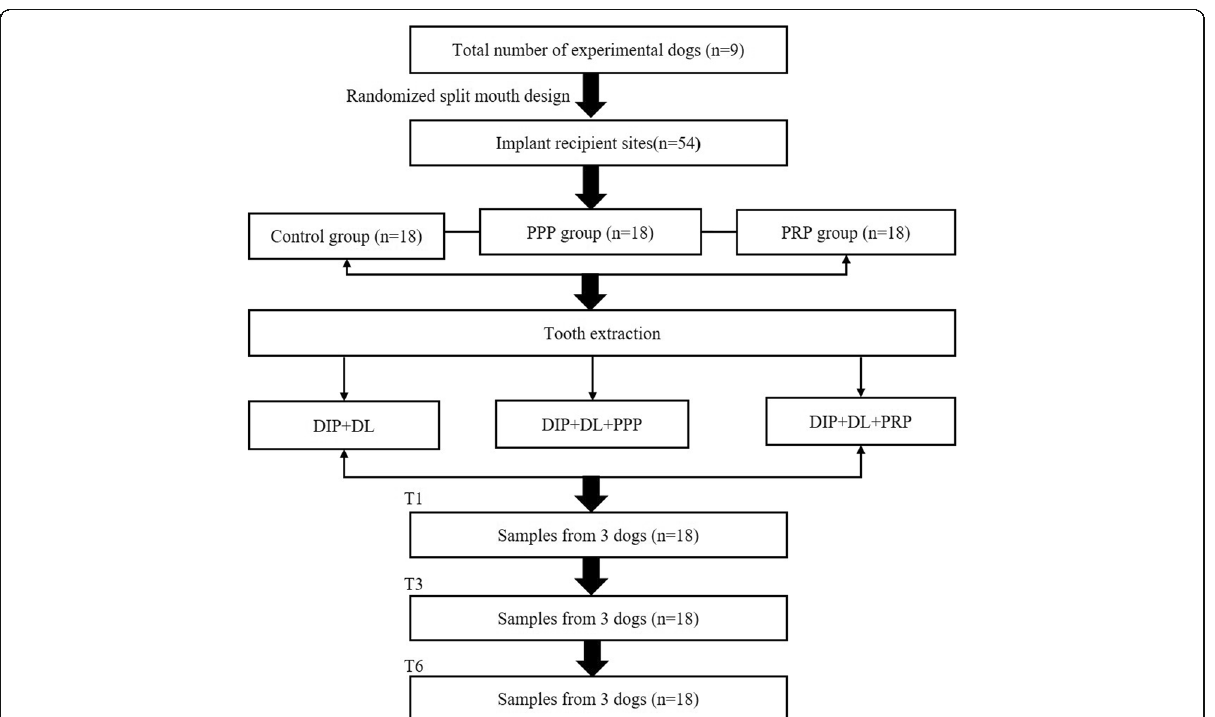
Fig. 1 Flow chart of study design. DIP+DL, delayed implant placement and delayed loading. PPP, platelet-poor plasma; PRP, platelet-rich plasma; T1, 1 month healing time; T3, 3 months healing time; T6 6 months healing